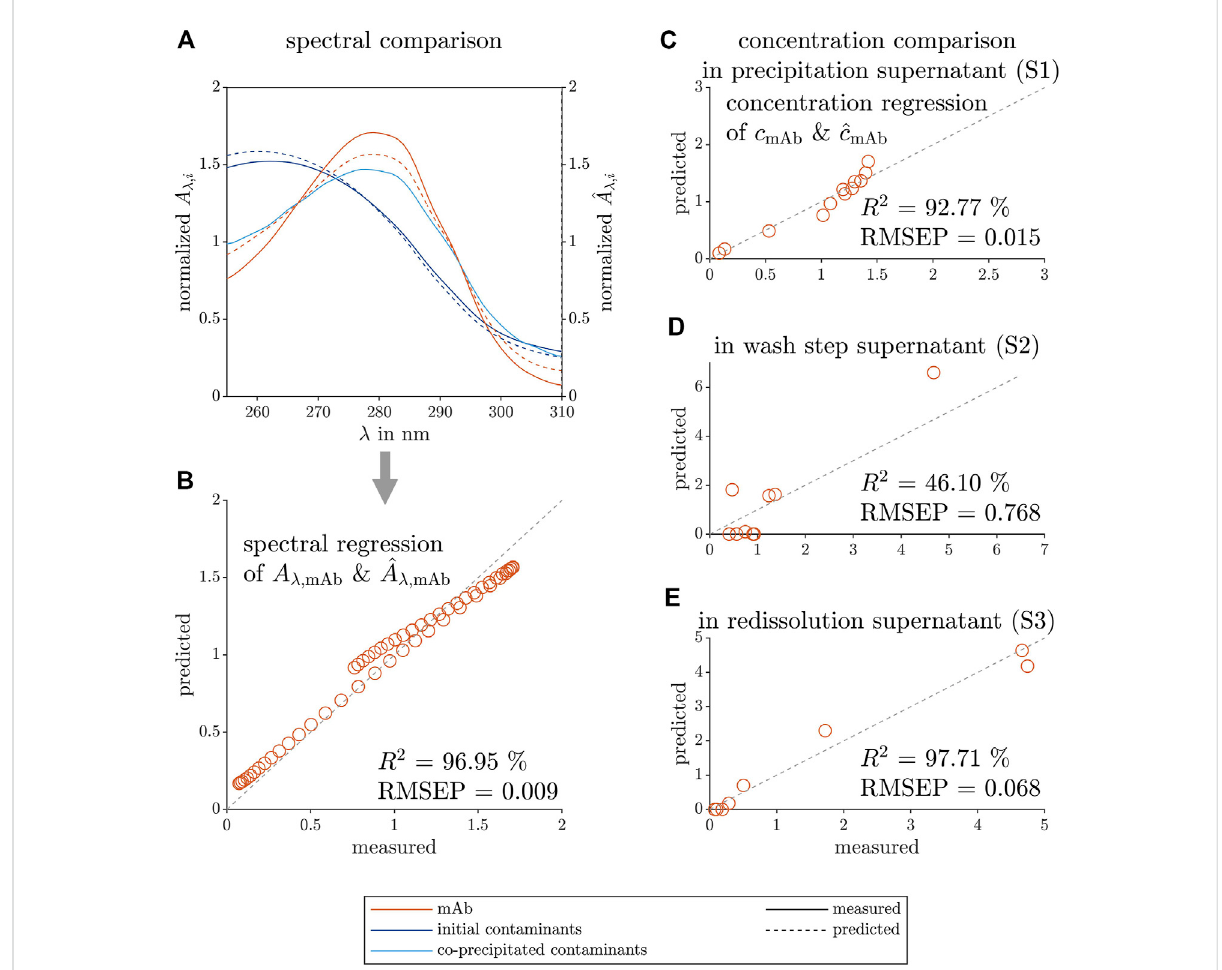
FIGURE 5 Comparison between predicted and measured data of the spectral and concentration loadings of the selective mAb precipitation screening. The measured reference data (left axis) and the predicted loadings (right axis) are illustrated with solid and dashed lines, respectively. The colors orange, dark blue, and light blue represent the target species mAb, the contaminating species before precipitation, and the remaining contaminant species after redissolution, respectively. The spectral predictions ^ A λ , i and measurements A λ , i are mean-normalized and depicted over the wavelength λ in (A) . The predicted spectral mAb loadings ^ A λ , mAb and the measured reference spectrum of puri fi ed mAb A λ ,mAb are used to plot the predicted over measured data in (B) . The predicted mAb concentration loadings ^ c mAb and measured concentration reference c mAb from mAb peak areas see (C – E) are mean-normalized and plotted against each other for the process steps of precipitation (C) , washing (D) , and redissolution (E) . These data were used to calculate the coef fi cient of determination R 2 values to quantify the validity of the constructed model. The gray dashed lines visualize the ideal fi t of the predicted to the measured data (B – E)